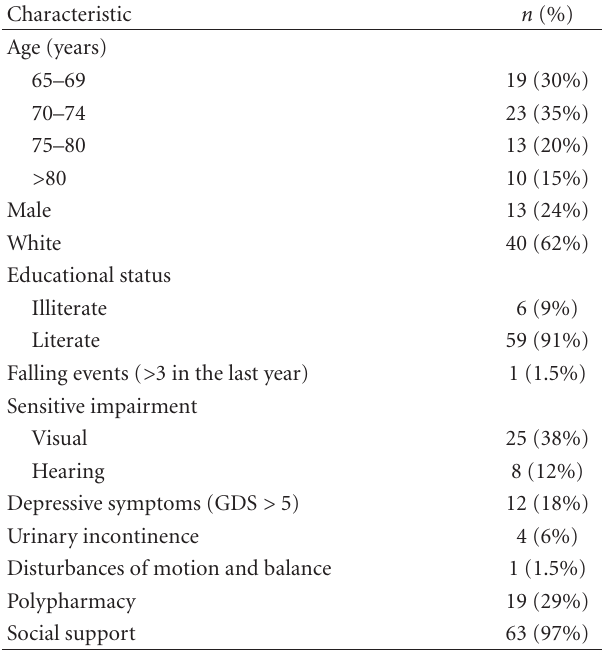
Table 1: General characteristics of the study population.